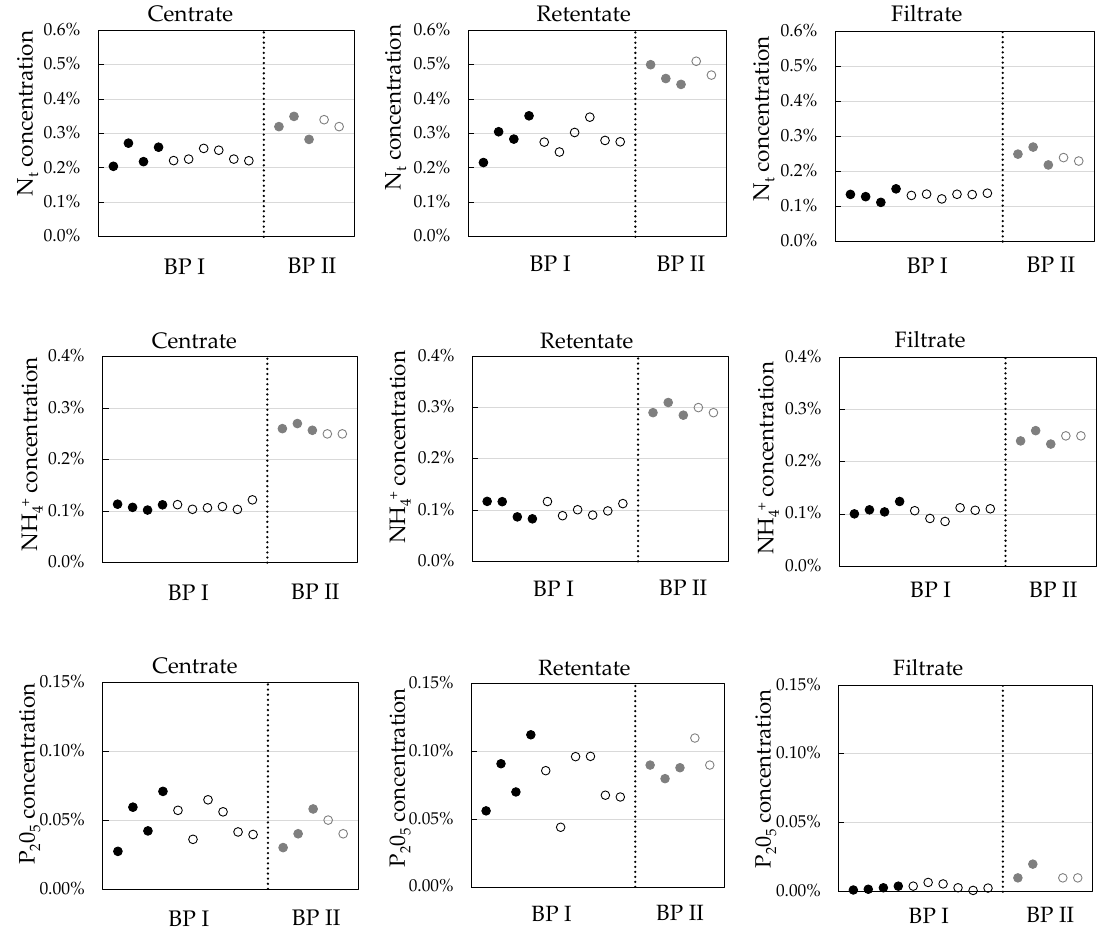
Figure 11. Comparison of total nitrogen, ammonium, and phosphorous concentrations without (full symbols) and with ozone treatment (open symbols) for BP I and BP II.